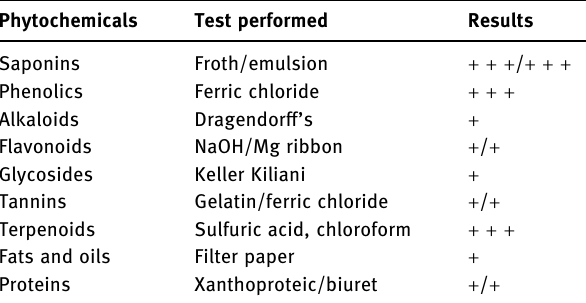
Table 1: Preliminary phytochemical evaluation of crude extract of